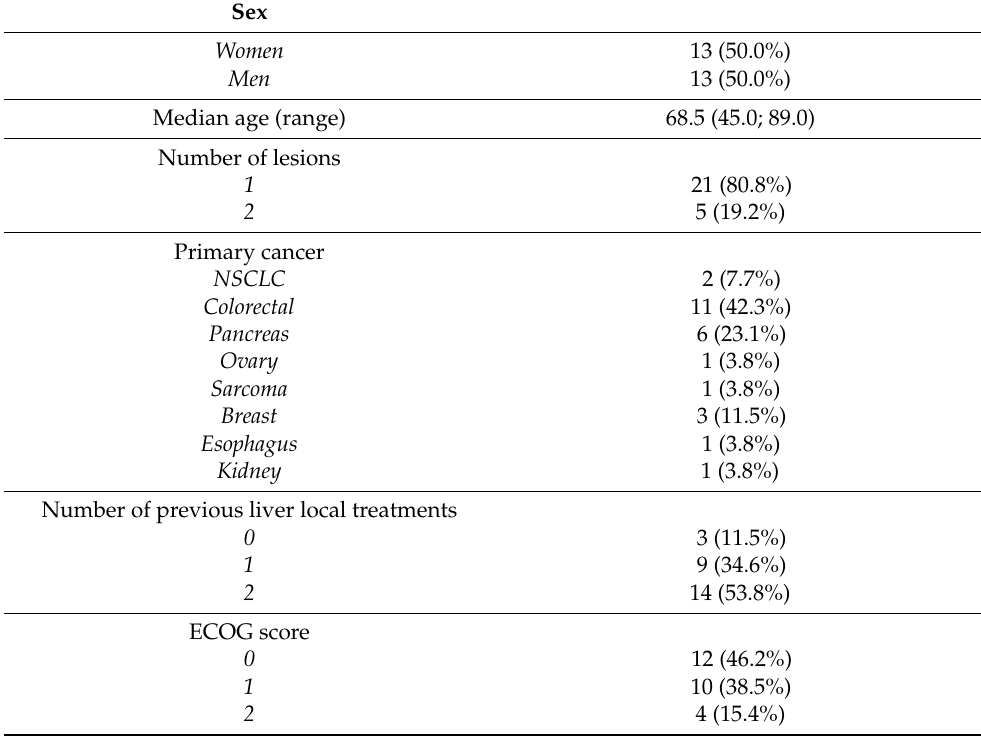
Table 1. Patients’ baseline